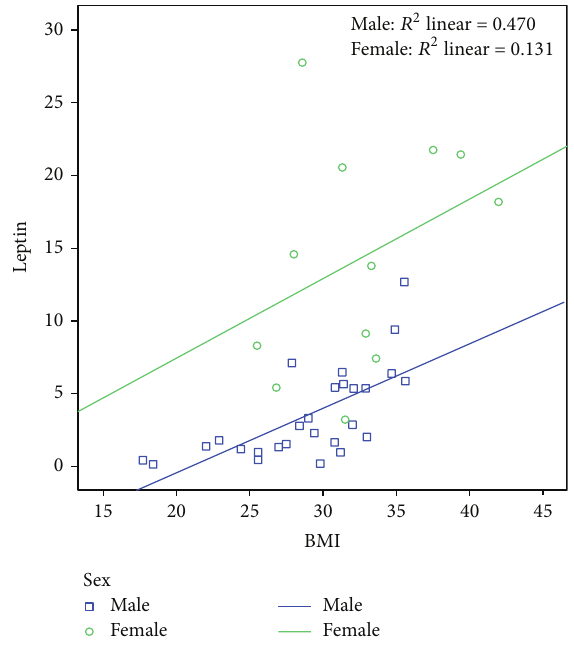
Figure 1: Correlation between leptin levels (ng/mL) with BMI (kg/m 2 ) in male and female PD